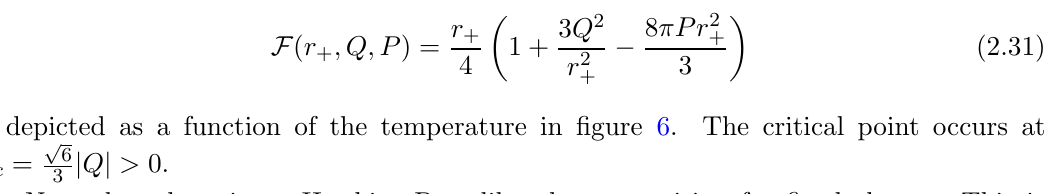
(cid:17) P v =T is a basic parameter used c c c c